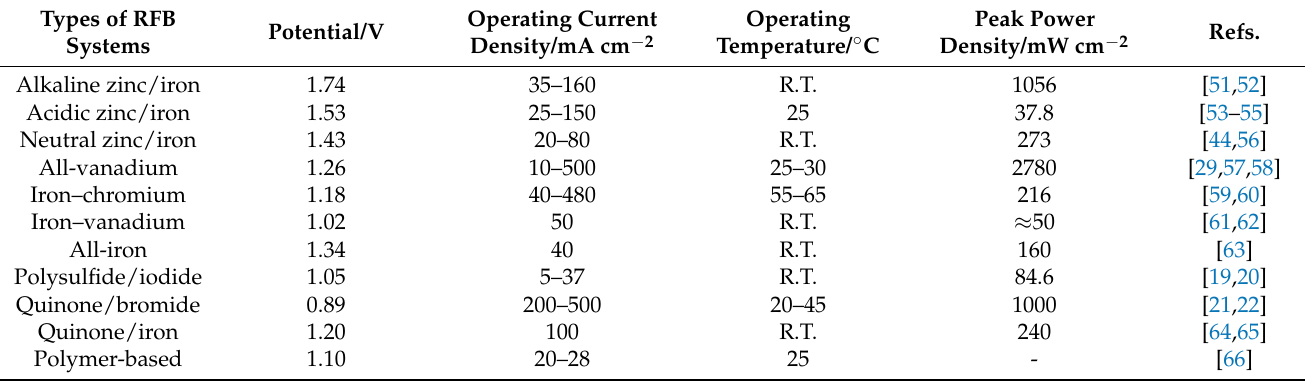
Table 2. The comparison of the ZIRFB system with conventional liquid–liquid RFB